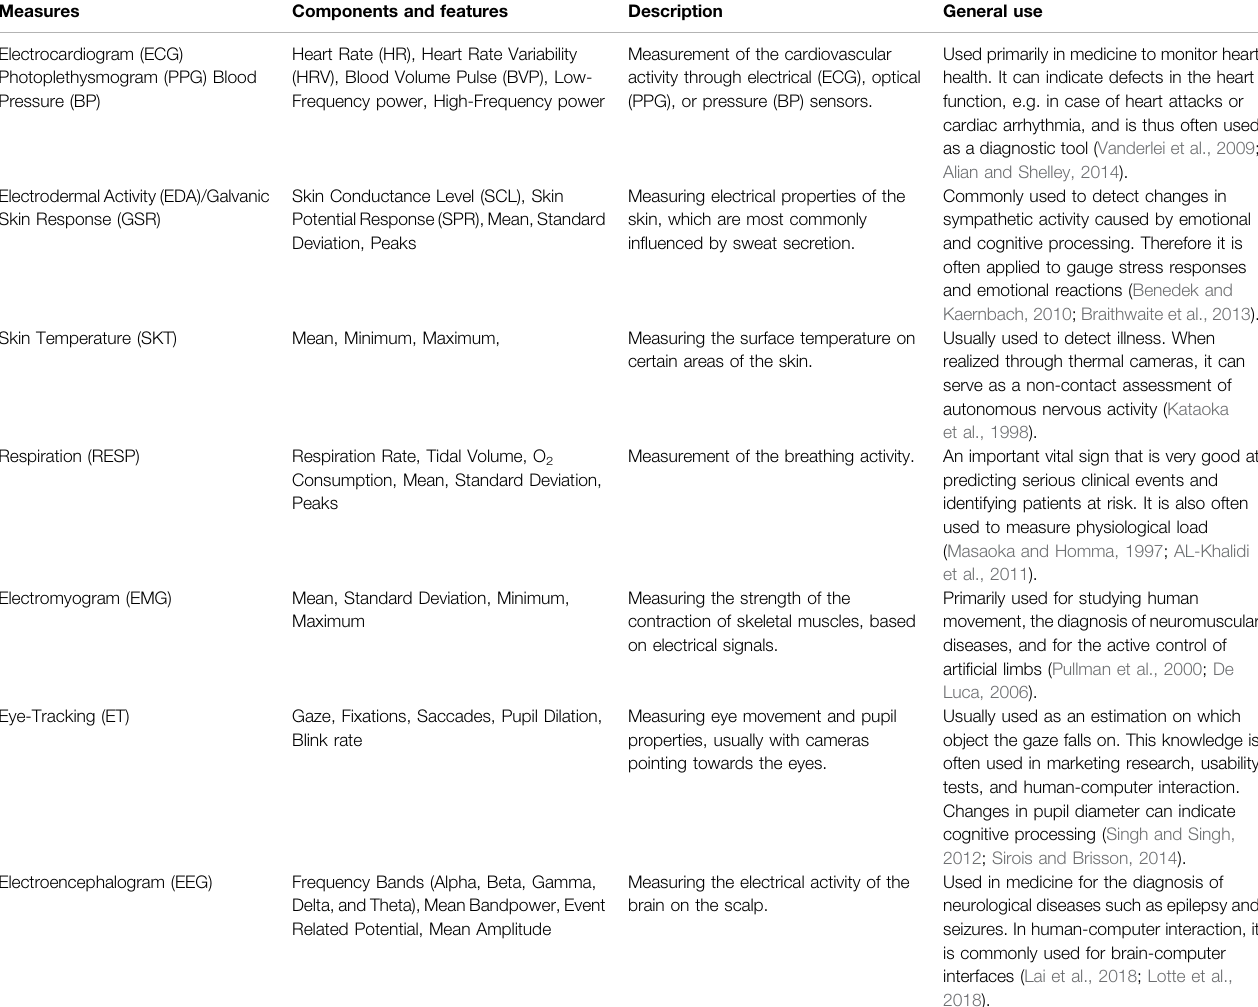
TABLE 1 | Physiological measures that are commonly used in VR